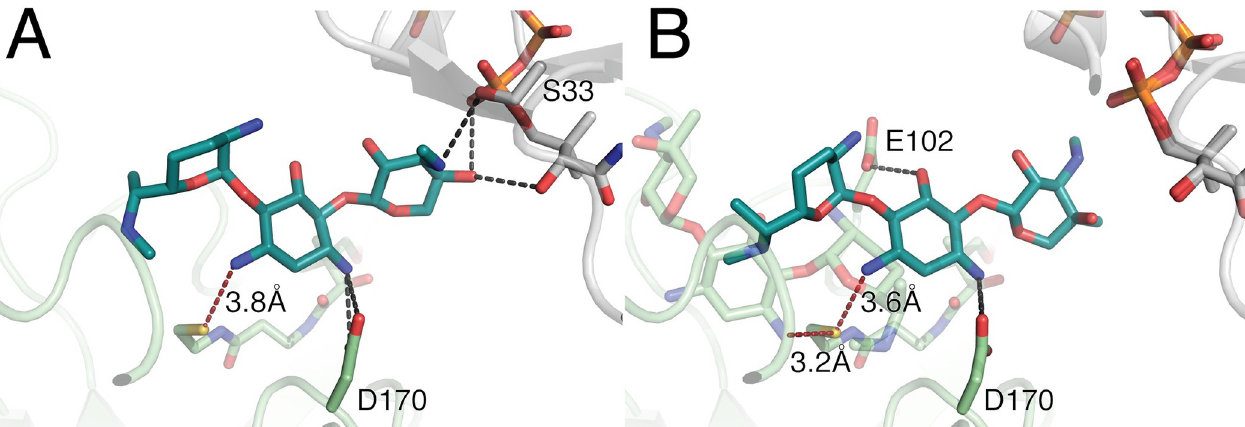
Fig 5. Interactions between AAC(3)-IIIa and gentamicin. Alternative binding conformation is shown in teal, and the symmetry mate in gray. Panel A represents the binding of gentamicin in chain A, where only one molecule of aminoglycoside was modeled. Panel B represents binding of gentamicin in chain B, where two molecules were alternative, and main (semi-transparent green) binders were modeled in. Hydrogen bonds between alternative mode of gentamicin binding and AAC(3)-IIIa are displayed in black, whereas distances between N-3 of the central ring are shown in burgundy.